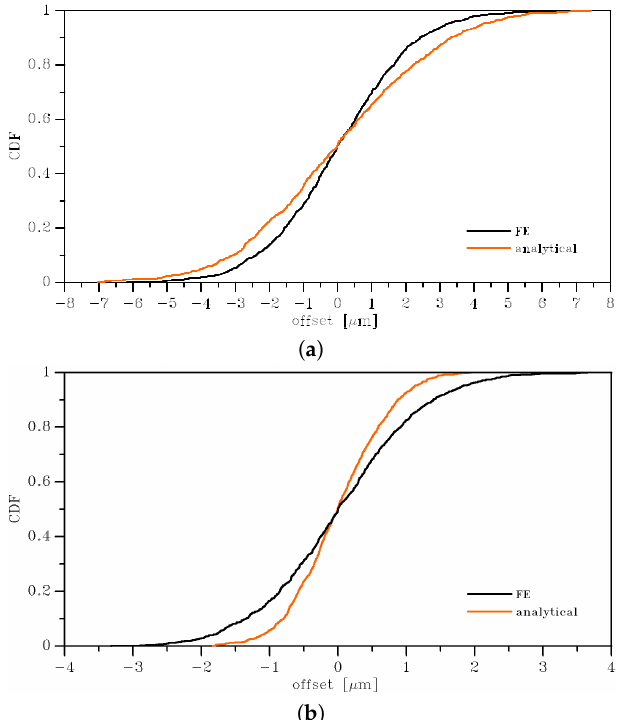
Figure 10. Offset from the rest position for length × SVE size cases: ( a ) 200 × 2 µ m 2 and ( b ) 200 × 3 µ m 2